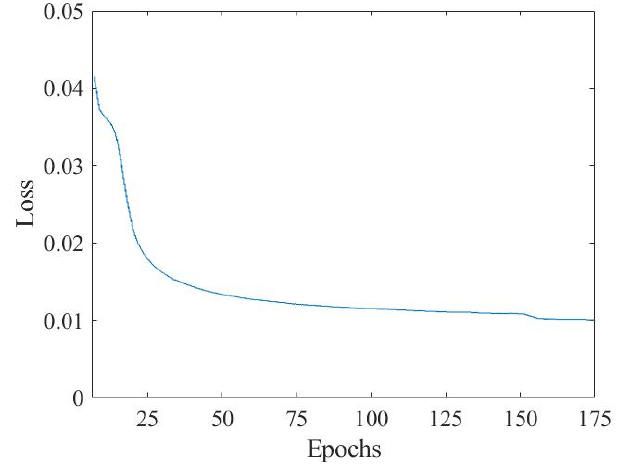
Figure 7. The relationship between the number of iterations of Epoch and Loss.